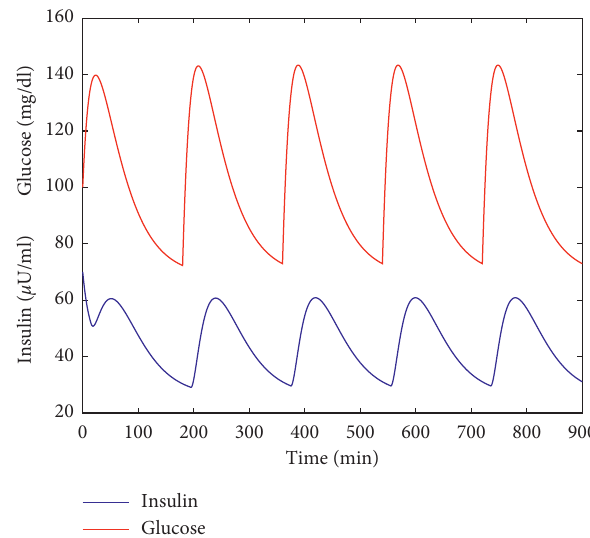
Figure 5: Changes of glucose and insulin levels of system